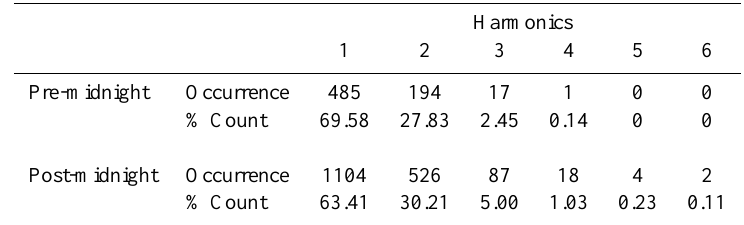
Table 1. Occurrence of tweeks in the period September to December